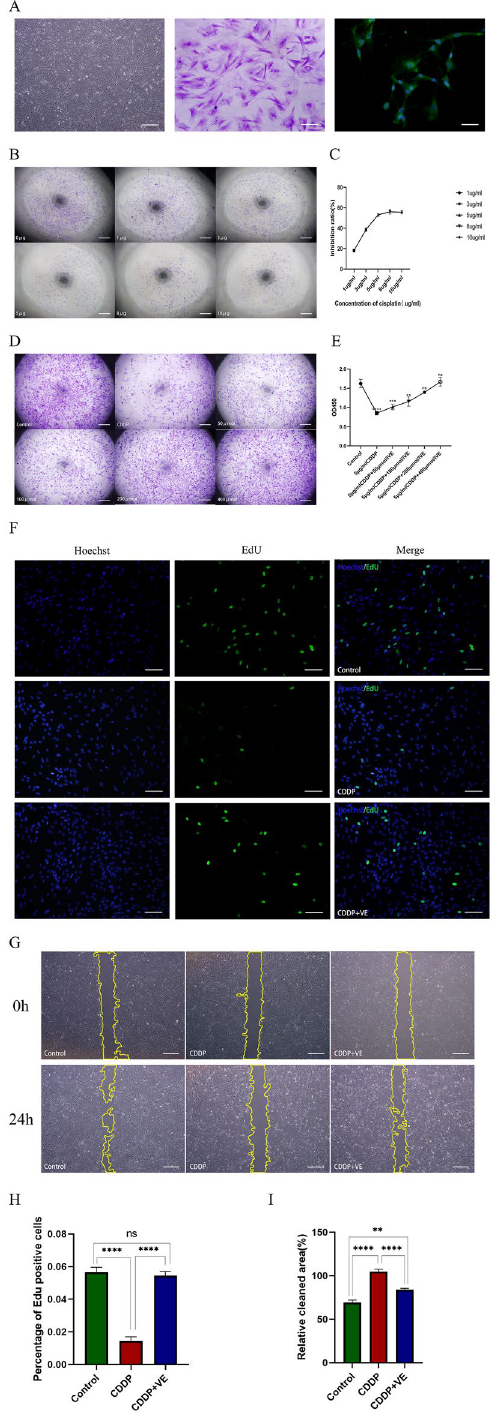
Figure 3. Effects of CDDP and VE on ovarian granulosa cell viability. ( A ) Morphology under light microscopy and crystal violet staining of ovarian granulosa cells (GCs), and identification of FSHR immunofluorescence specifically expressed by GCs. Respectively scale bars are: 500 μm, 100 μm, 50 μm. ( B , C ) The inhibition rate of CDDP at different concentrations on the proliferation of GCs was determined by CCK8. Scale bar 500 μm. ( D , E ) CCK8 determined the viability of granulosa cells after CDDP injury with different concentrations of VE. Scale bar 500 μm. (F, G, H, I) EdU and wound healing assays were performed to determine the proliferation, migration motility, and repair capacity of the injured GCS after the addition of 200 μmol/l VE to the culture medium. Data are expressed as the means ± SEM. EdU scale bar 100 μm, wound healing scale bar 500 μm. * P < 0.05, ** P < 0.01, *** P < 0.001 and **** P < 0.0001, ns indicates no statistical